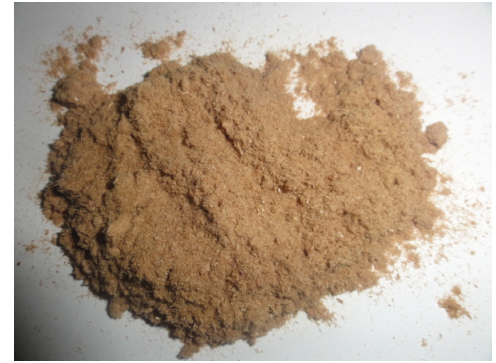
Figure 1. Wood destination and derivatives of Furniture Industry of Bento Gonçalves – RS. Souce: Author.